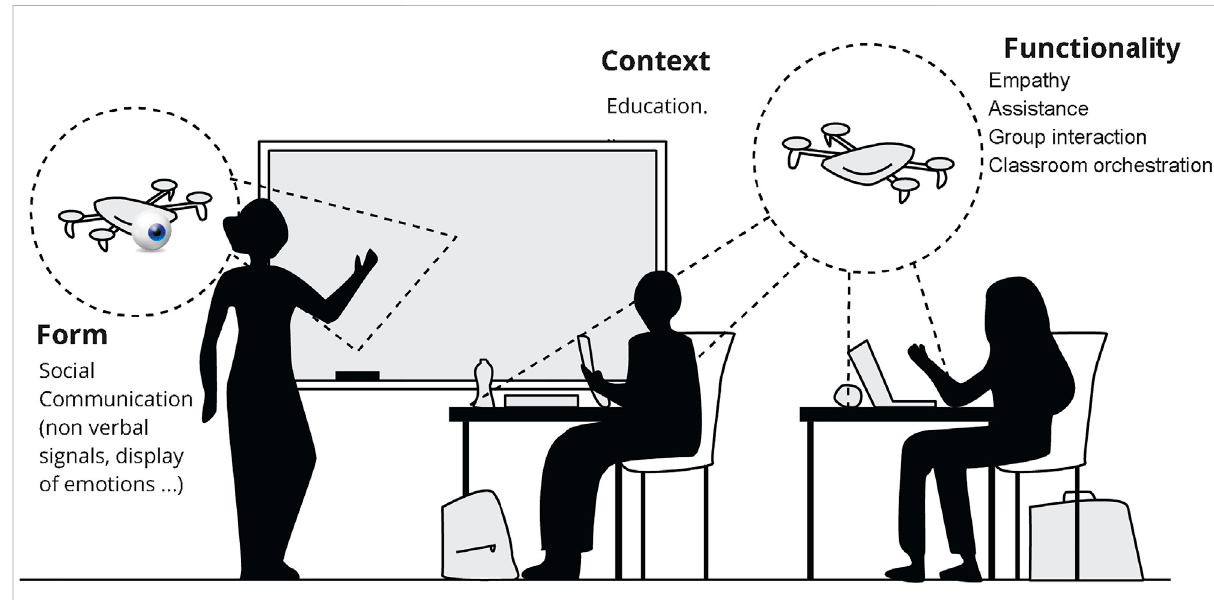
FIGURE 1 An illustration of social drones in a classroom, with examples of instantiating the social form and social function in an educational context [extending the de fi nition by Hegel et al.